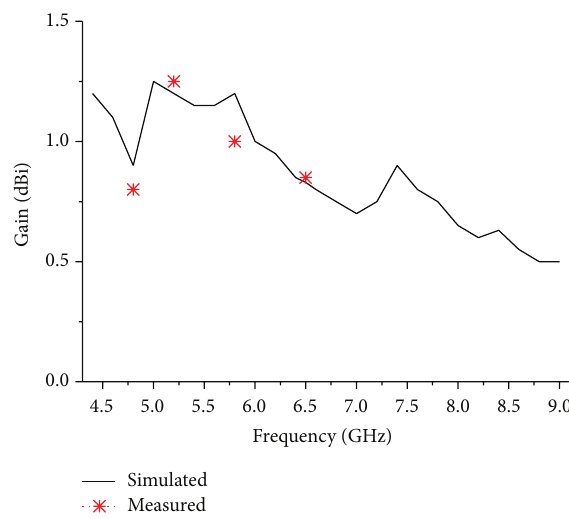
Figure6:Simulatedandmeasuredresultsofthemicrowaveantenna